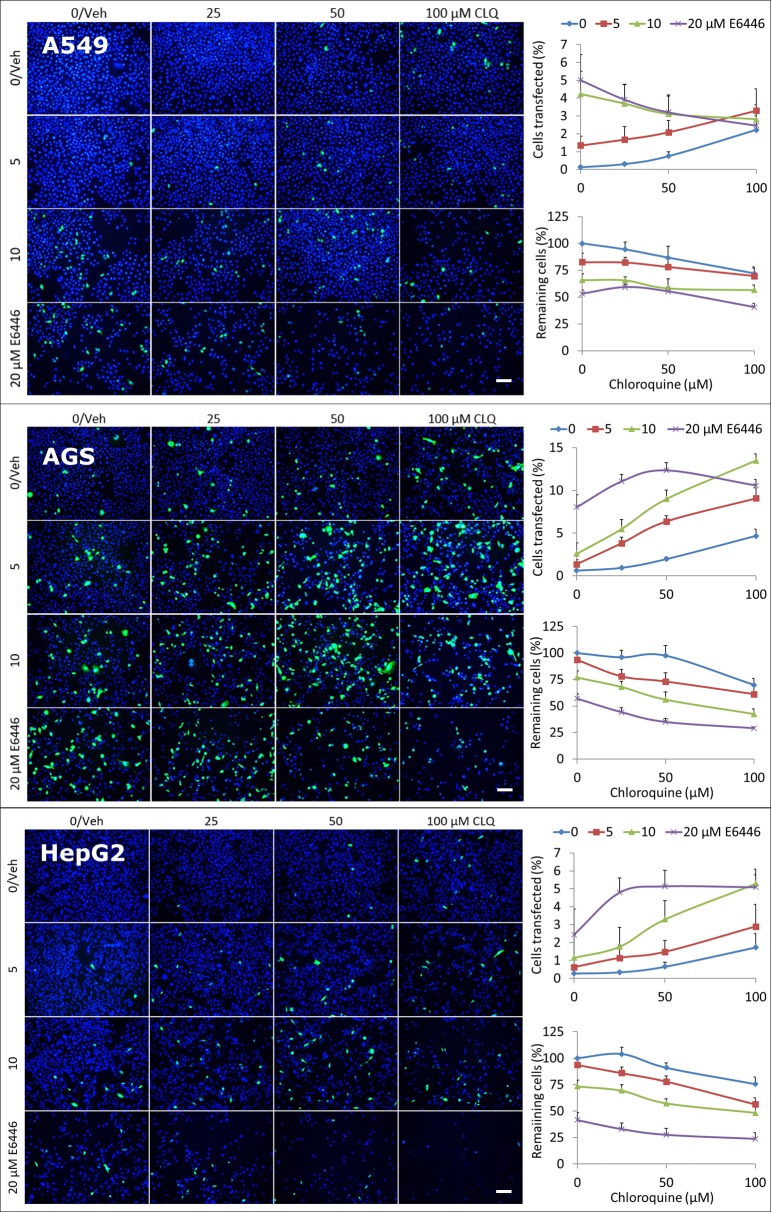
Comparing E6446 and CQ for their ability to enhance XP-mediated transfection of EGFP mRNA.Fluorescence imaging of EGFP expression (green) in A549, AGS, and HepG2 human cancer cell lines 24 h after treatment with EGFP mRNA mixed with XP, E6446 (0–20 μM), and CQ (0–100 μM). Quantified for each cell line and treatment condition are the percentages of cells expressing EGFP (top graph in each panel) and the cell counts relative to vehicle-treated controls (bottom graph in each panel). Data are shown as mean ± 95% confidence interval and are representative of 4+ independent experiments. Cell nuclei are stained blue with DAPI. Veh = vehicle; scale bars = 100 μm.